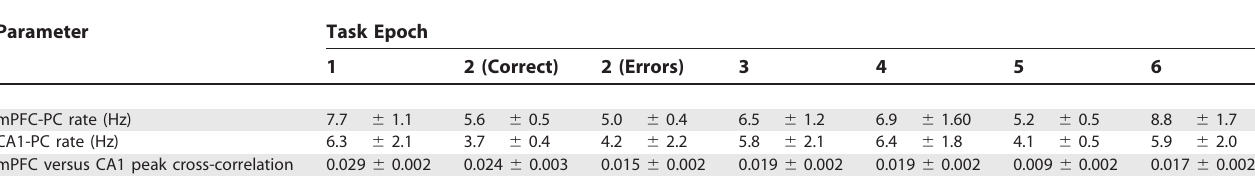
Table 2. Summary of Mean Firing Rates and Mean Peak Cross-Correlation Coefficients between CA1–mPFC Neuron Pairs during the Different Task Epochs Shown in Figure 1B